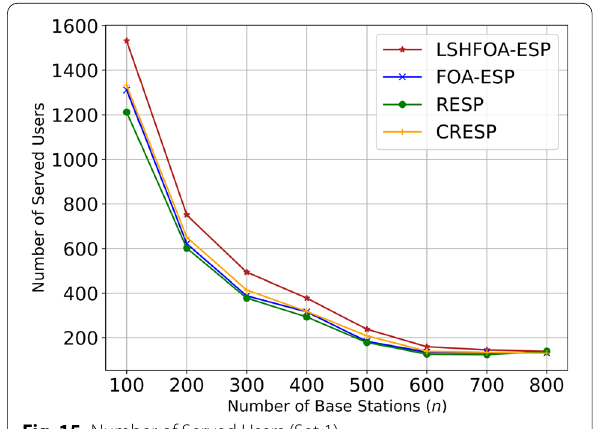
Fig. 15 Number of Served Users (Set